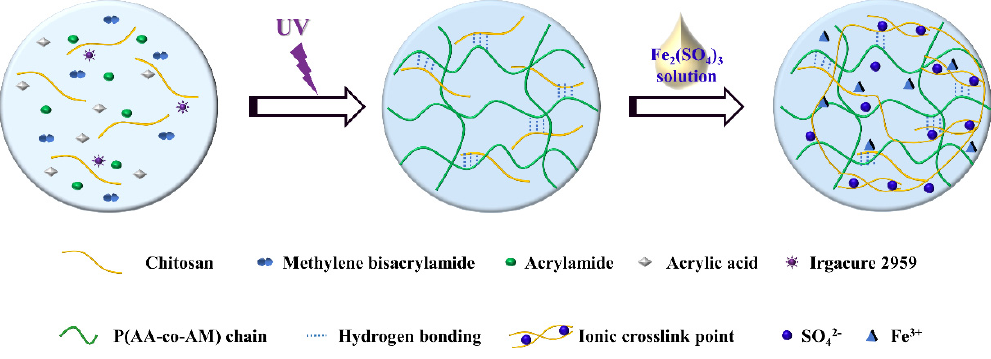
Figure 1. The schematic diagram of the preparation of CS/P(AA-co-AM) DN